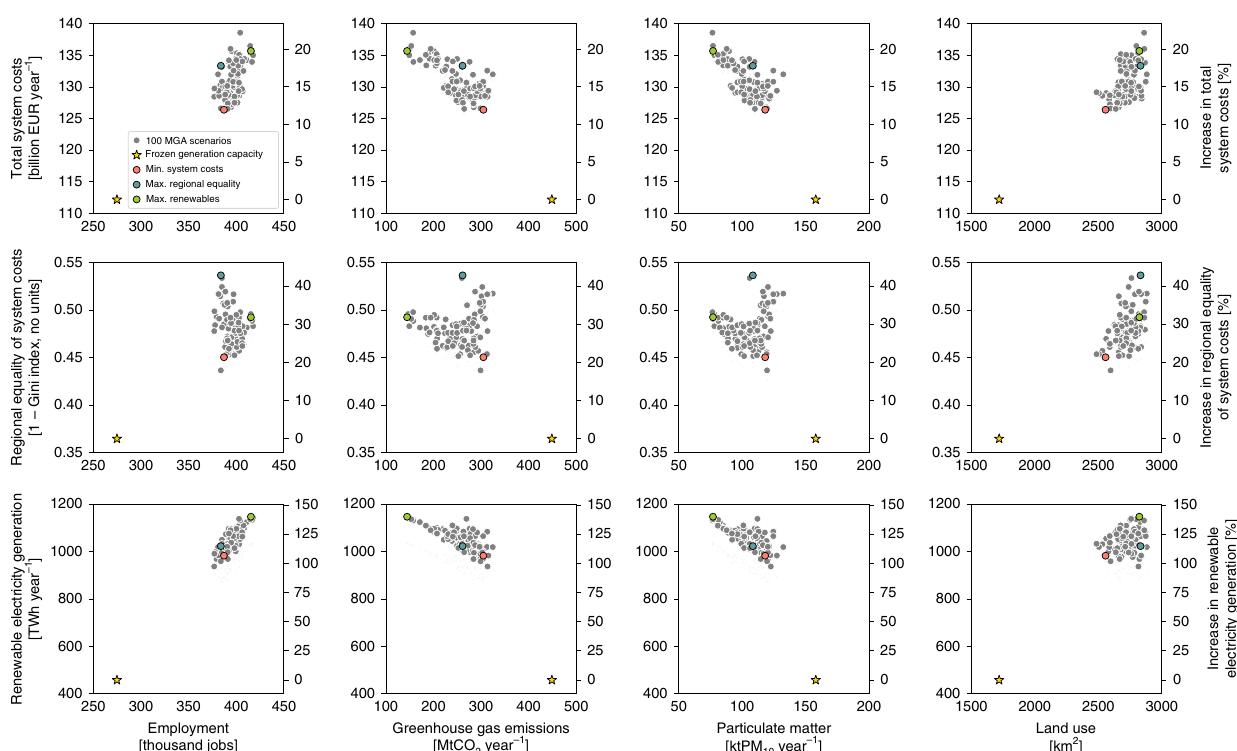
Fig. 6 Costs, regional equality, renewable electricity generation, and impacts in 2035. Trade-off between regional impacts and total system costs, regional equality of system costs per capita, and renewable electricity generation. Regional impacts include employment, greenhouse gas and particulate matter emissions, and land use. Gray scatter points depict the 100 MGA scenarios. We additionally highlight the four distinct scenarios of frozen generation capacity, minimum system costs, maximum regional equality of system costs, and maximum renewable electricity generation. Percentage values on the second y -axis are relative to the frozen generation scenario. MGA scenarios are generated with a slack of 20% above total levelized electricity generation costs of the cost-optimal solution in EXPANSE model and assuming that each country meets its national electricity generation targets for 2035 (see “ Methods ” ). Source data are provided in Supplementary Data 1.